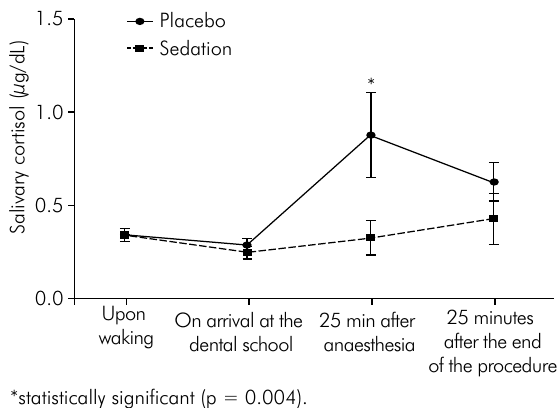
Figure 2. Comparison of patients’ salivary cortisol levels (mean and standard deviation, in µg/dL) during dental treatment with sedation (MS) and placebo (PS) at different collection times. Paired Student’s